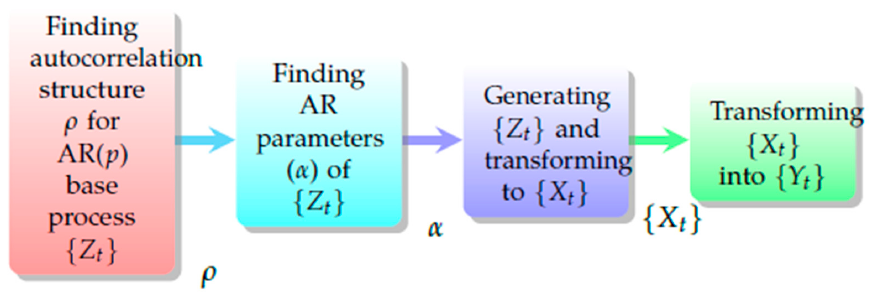
Figure 1. A Diagram for Sample Generation